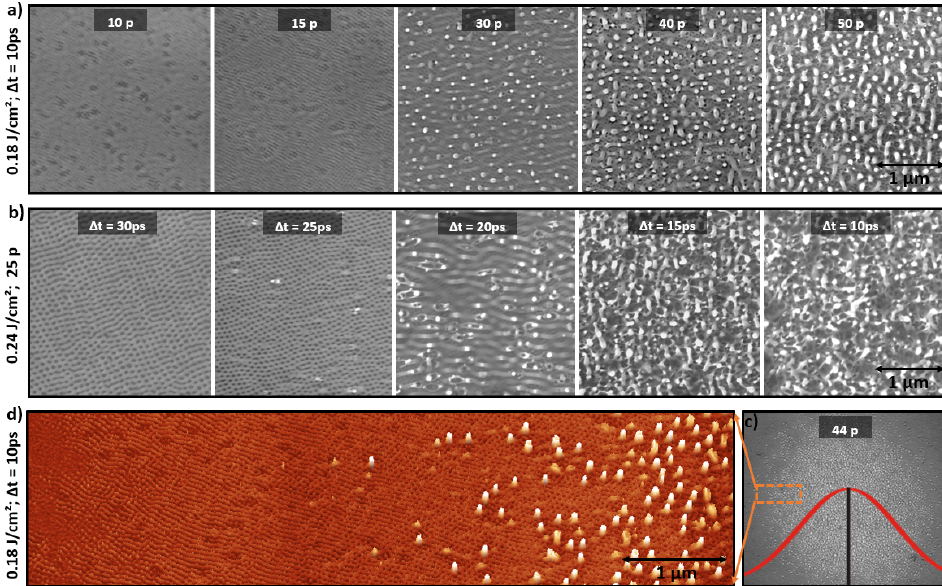
Figure 4. ( a ) 2D scanning electron microscopy (SEM) images presenting the influence of the N DPS in enhancing nanostructures at a fixed time delay. ( b ) 2D SEM images of growing nanopatterns by decreasing the time delay at a fixed peak fluence of 0.24 J/cm 2 and N DPS = 25. ( c ) 2D SEM image of the gaussian laser spot at a fixed laser parameters (0.18 J/cm 2 ; 10 ps; N DPS = 44). ( d ) The left region of the gaussian laser spot, showing the significant role of laser fluence in controlling different types of